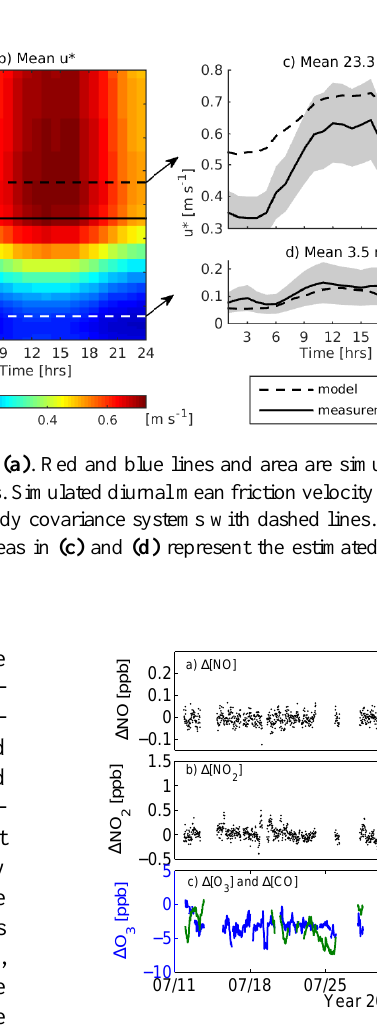
Figure 5. Difference in measured gas concentration of (a) NO , (b) NO 2 , and (c) O 3 (blue, left hand Figure 6. Difference in measured gas concentration of (a) NO, side) and CO (green, right hand side). The difference is calculated by subtracting the campaign (b) NO 2 and (c) O 3 (blue, left-hand side) and CO (green, right-hand measured concentrations by the SMEAR II obtained concentrations. side). The difference is calculated by subtracting the campaign- measured concentrations by the SMEAR II-obtained concentra-